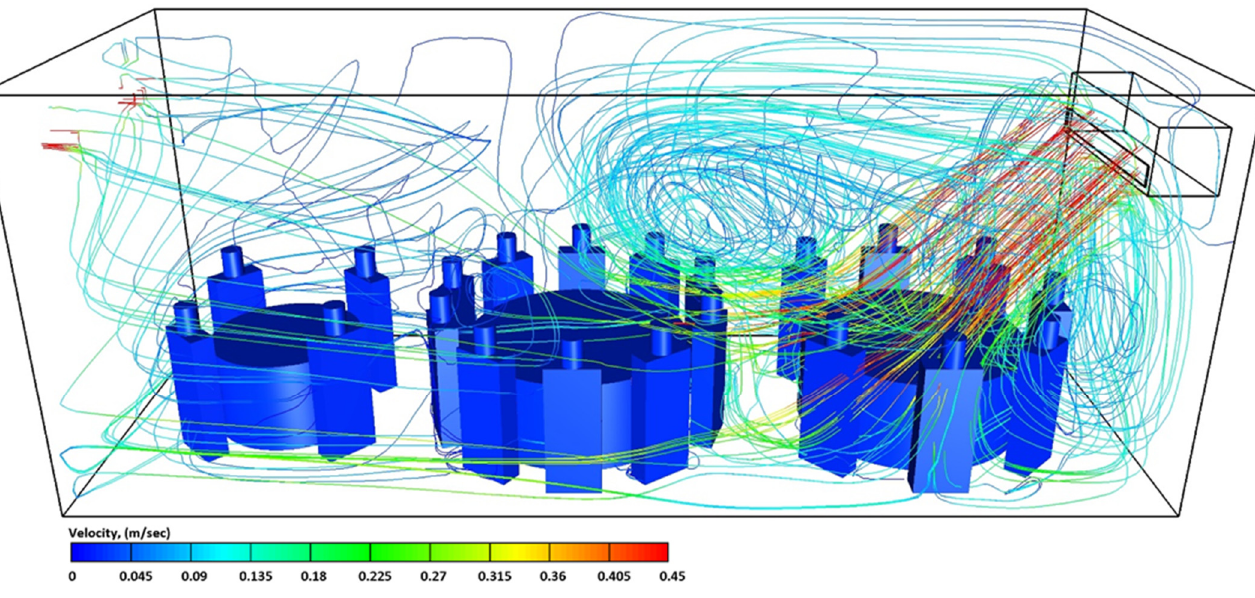
Figure 12. The airflow streamlines velocities in the computational domain at t = 4500 s for case-3.